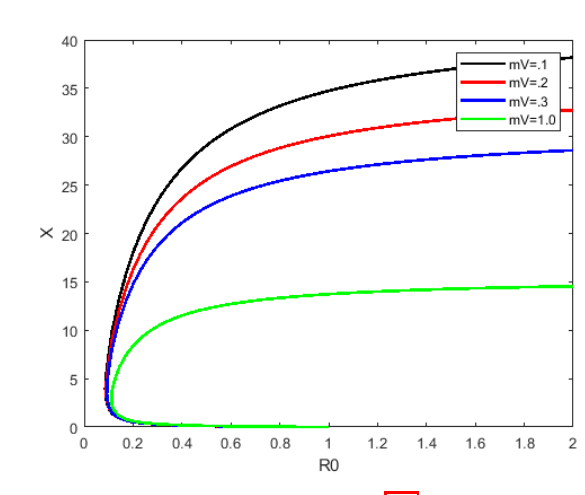
Fig. 3: Backward bifurcation of (24) when R 0 < 1 and b 0 < 0 . Various values of m V are